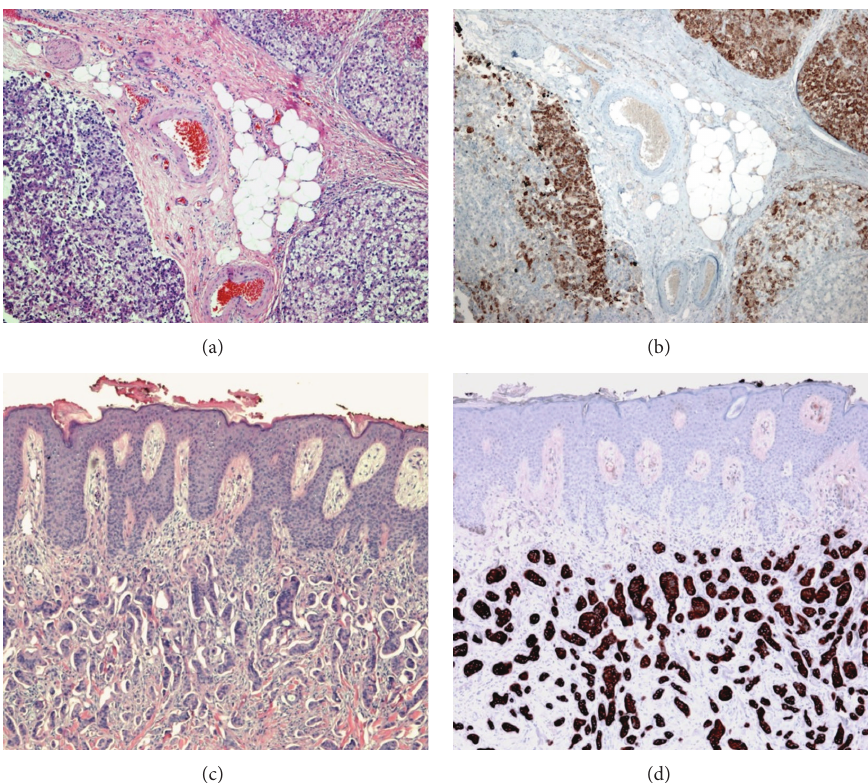
Figure 2: (a) H&E staining of abdominal wall excisional biopsy showing nodules of tumor cells with intervening entrapped soft tissue. Tumor cells demonstrate large variation in size with moderate nuclear pleomorphism; many tumor cells show cytoplasmic clearing. (b) Tumor cells show strong focal cytoplasmic reactivity for HepPar-1 supporting a diagnosis of metastatic HCC. (c) H&E staining of punch biopsy of skin showing tumor cells in the dermis streaming in cords and trabeculae with occasional gland-like formations. Tumor cells are hyperchromatic with increased nuclear-to-cytoplasmic ratio. (d) Tumor cells highlighted by CK7 immunohistochemistry (brown), showing diffuse strong cytoplasmic reactivity. Tumor cells were also positive for EMA and focally positive for mucicarmine; CK20, HepPar-1, CDX-2, and PSA were negative. The immunoprofile (CK7(+), CK20( − ), and HepPar-1( − )) supports biliary over hepatic origin but is not